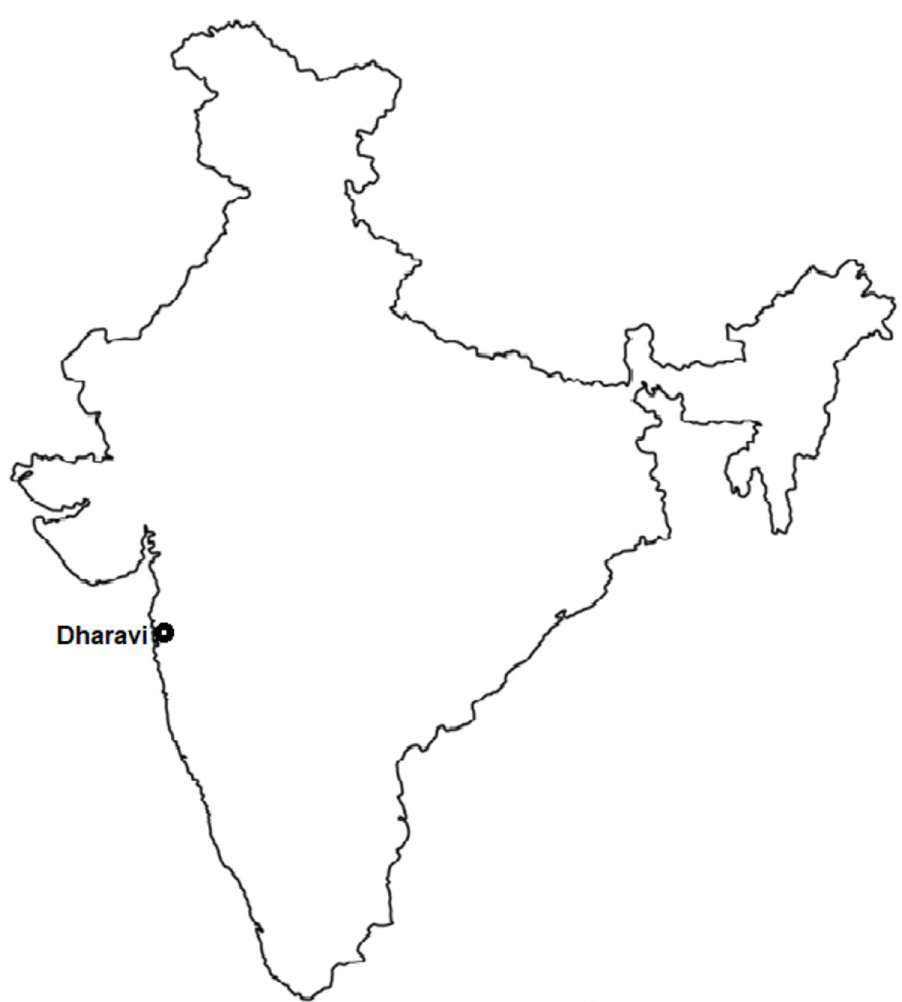
Fig 1. Map of India showing the location of